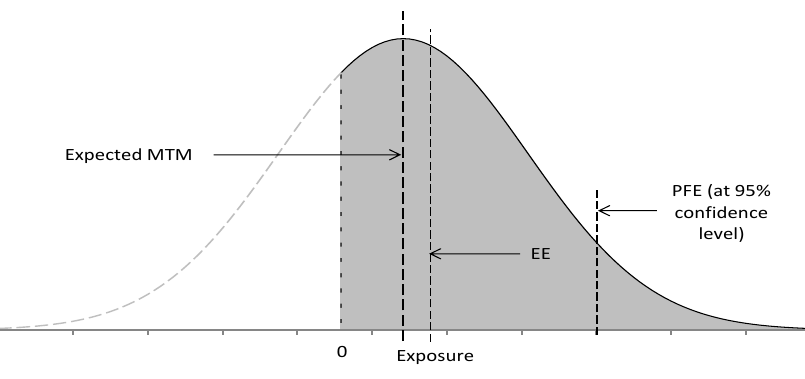
Exposure metrics EE and PFE. Positive exposures (of concern to the institution) are represented by the shaded